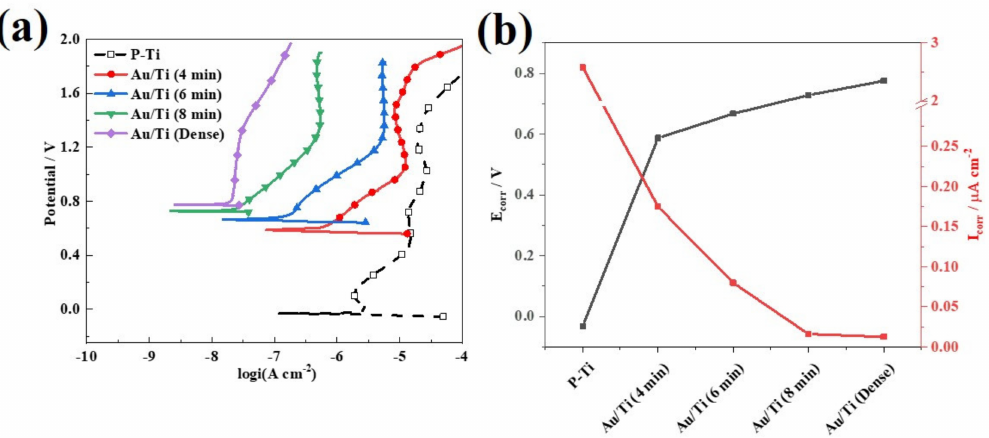
Figure 5. Potentiodynamic test results of the P-Ti and Au/Ti prepared with different electrical pulse times: ( a ) polarization curves; ( b ) E corr and I corr